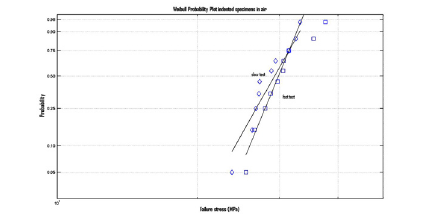
Figure 12: Micrograph of